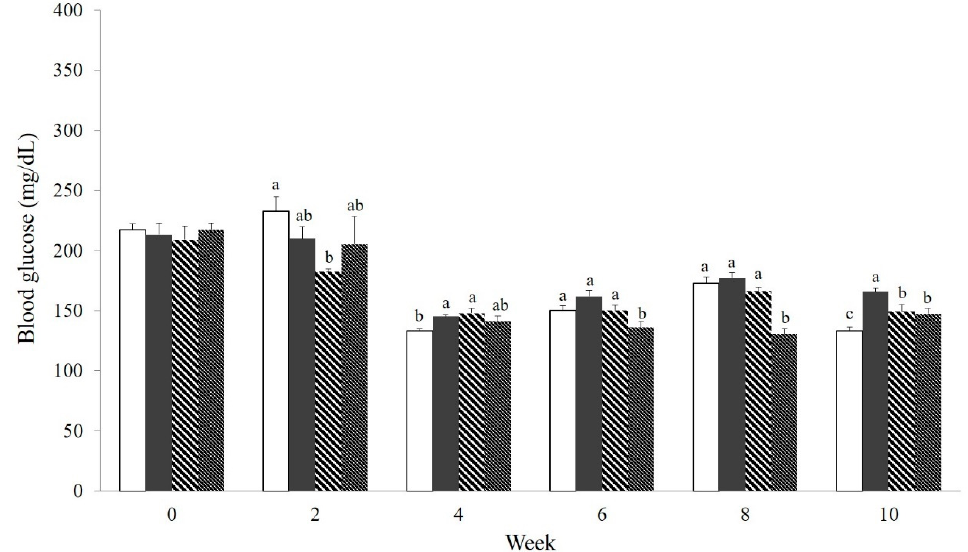
Figure 3. Effect of Nelumbinis Semen powder on random blood glucose levels at weeks 0, 2, 4, 6, 8, and 10 in C57BL/6 mice. , CON, control group; , HFD, high-fat diet; , HFD-NS5%, high-fat